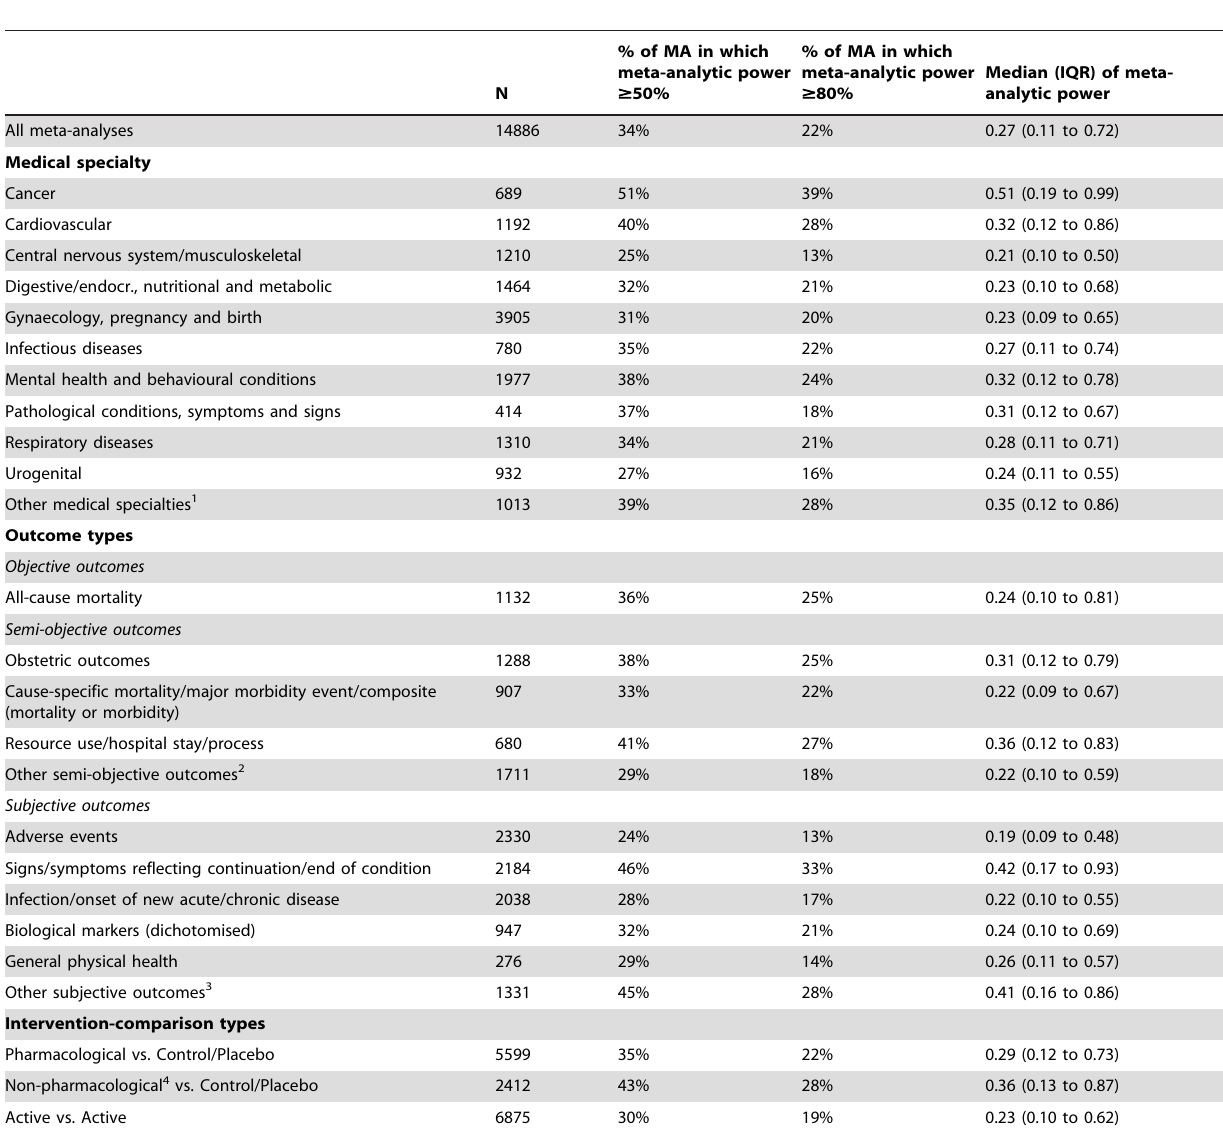
Table 3. Meta-analytic power with respect to a 30% relative risk reduction (RRR30), based on the random-effects model, overall and by medical specialty, outcome type and intervention-comparison